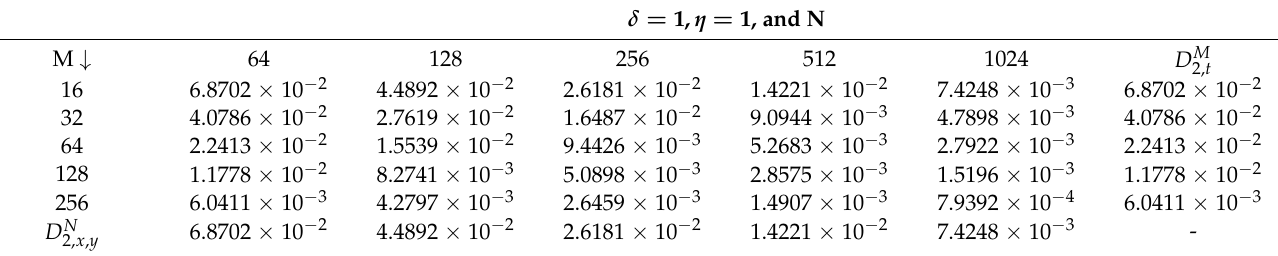
Figure 6. The surface plot illustrates the numerical solution, U 2 , for Case 3 in Example 1. Table 2. U 2 — the component maximum error for Example 1 in Case